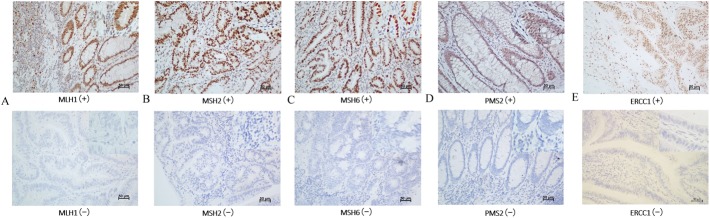
Illustrative immunostainings.A: MLH1(+) and (-); B:MSH2 (+) and (-); C: MSH6 (+) and (-); D: PMS2 (+) and (-); E: ERCC1 (+) and (-).